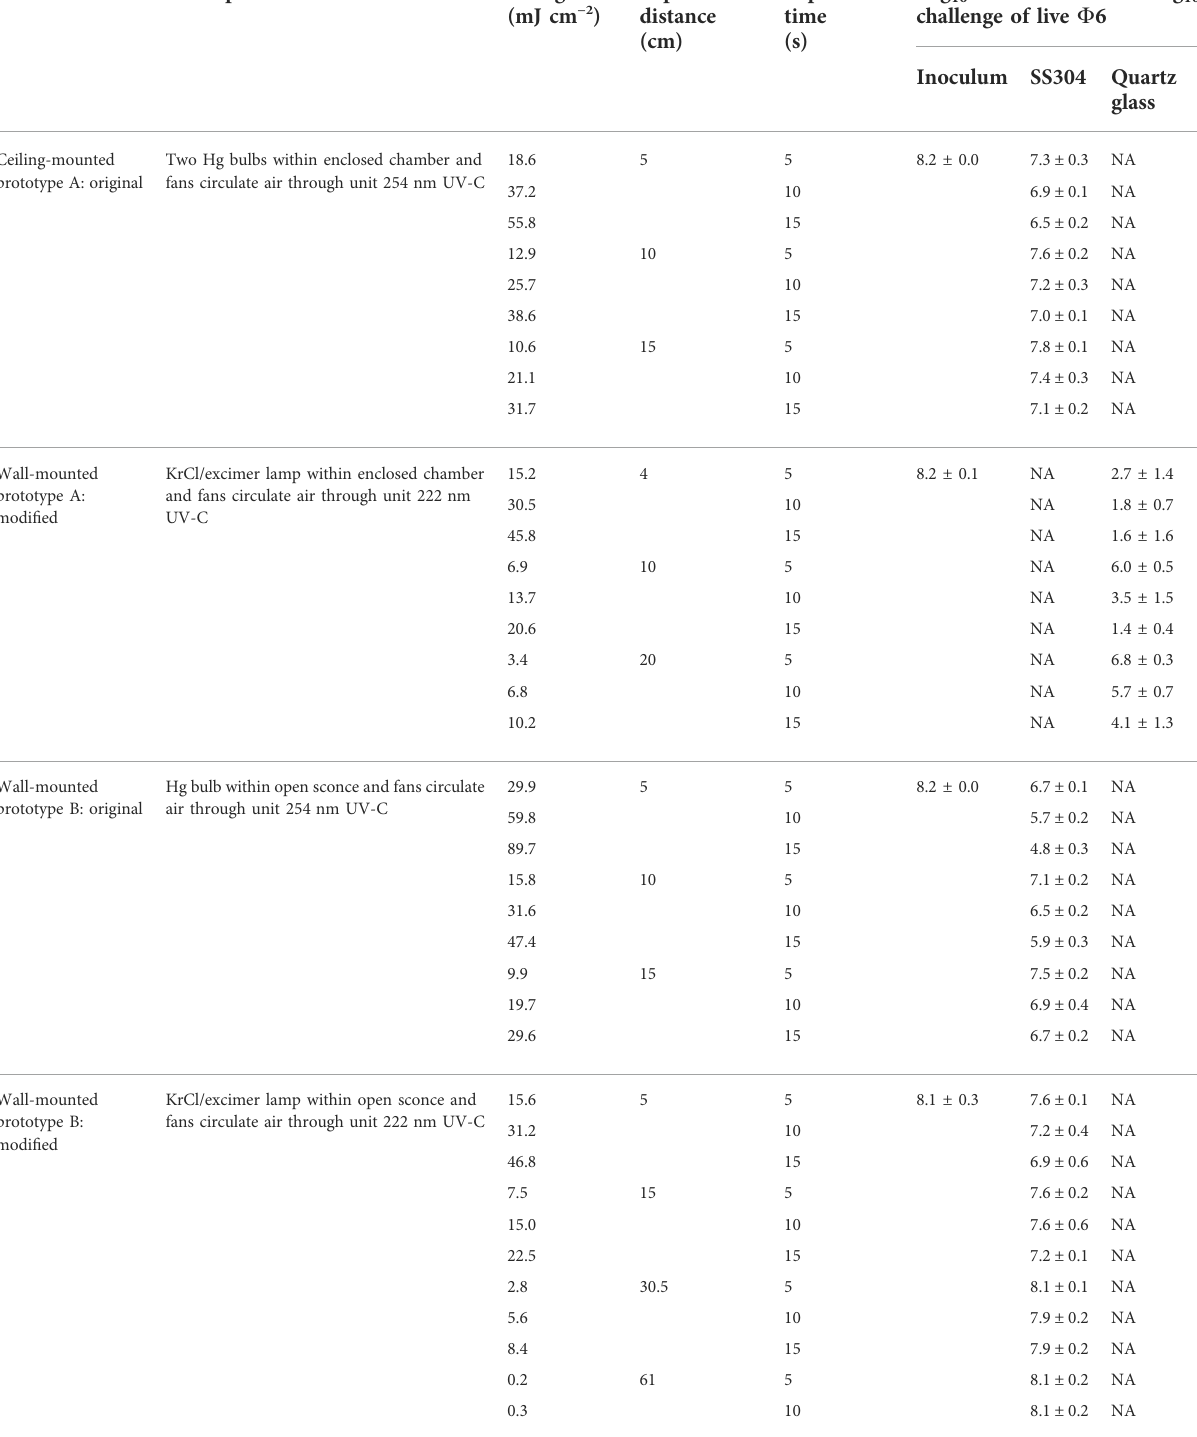
TABLE 5 Dosage and ef fi cacy of room air-irradiating prototypes showing log 10 survival data based on the average power from the bulb area, not the peaks. White (low decontamination) = Fail < 2 log 10 ; yellow (sanitation) = Fail ≥ 2 log 10 , < 3 log 10 ; light blue (disinfection) = Pass ≥ 3 log 10 ; and dark blue (approaching virus sterilization) = Pass ≥ 6 log 10 . N/A — dosage measurements had no meaning because of the broad-spectrum Xe